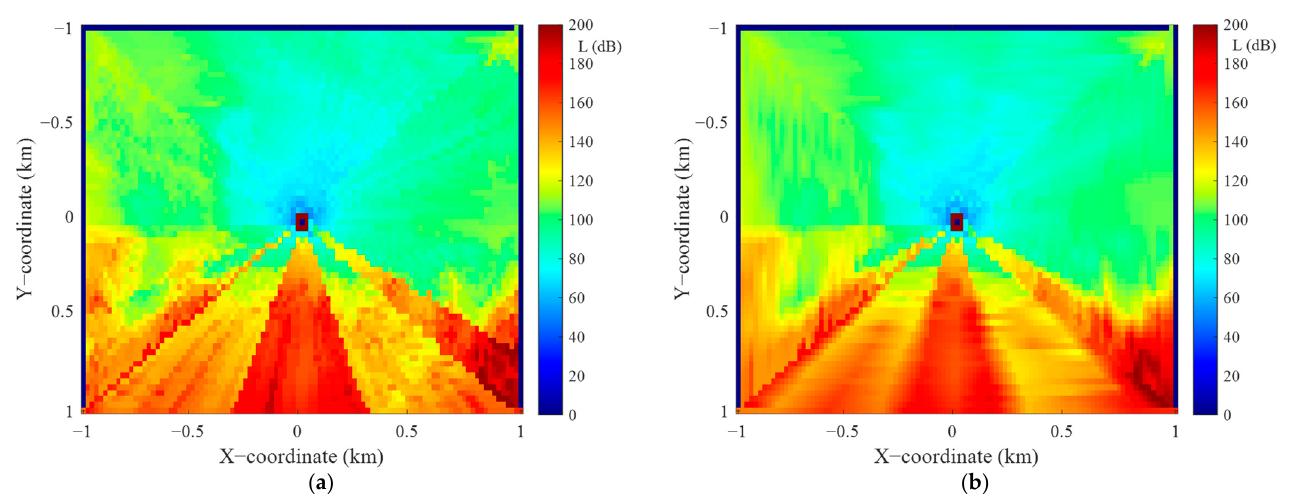
Figure 12. PAMs for selected angular resolutions ( a ) Δα = 2° and ( b ) Δα = 10°.